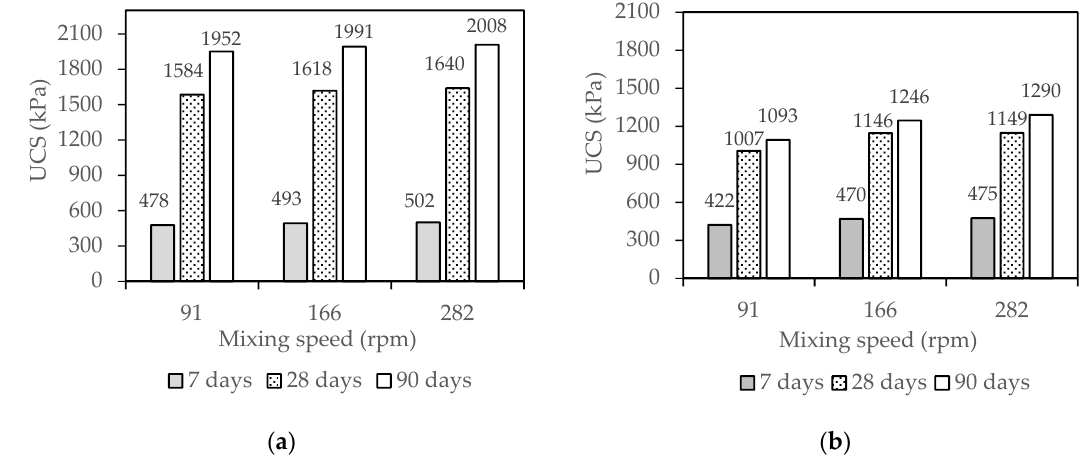
Figure 6. Variation of the unconfined compressive strength (UCS) at curing times of 7, 28 and 90 days with mixing speed for: ( a ) CPB-T1 and ( b ) CPB-T2.